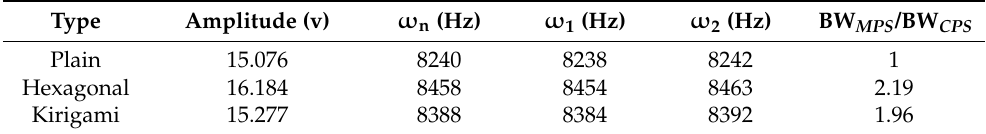
Table 4. 3 dB bandwidth of the proposed